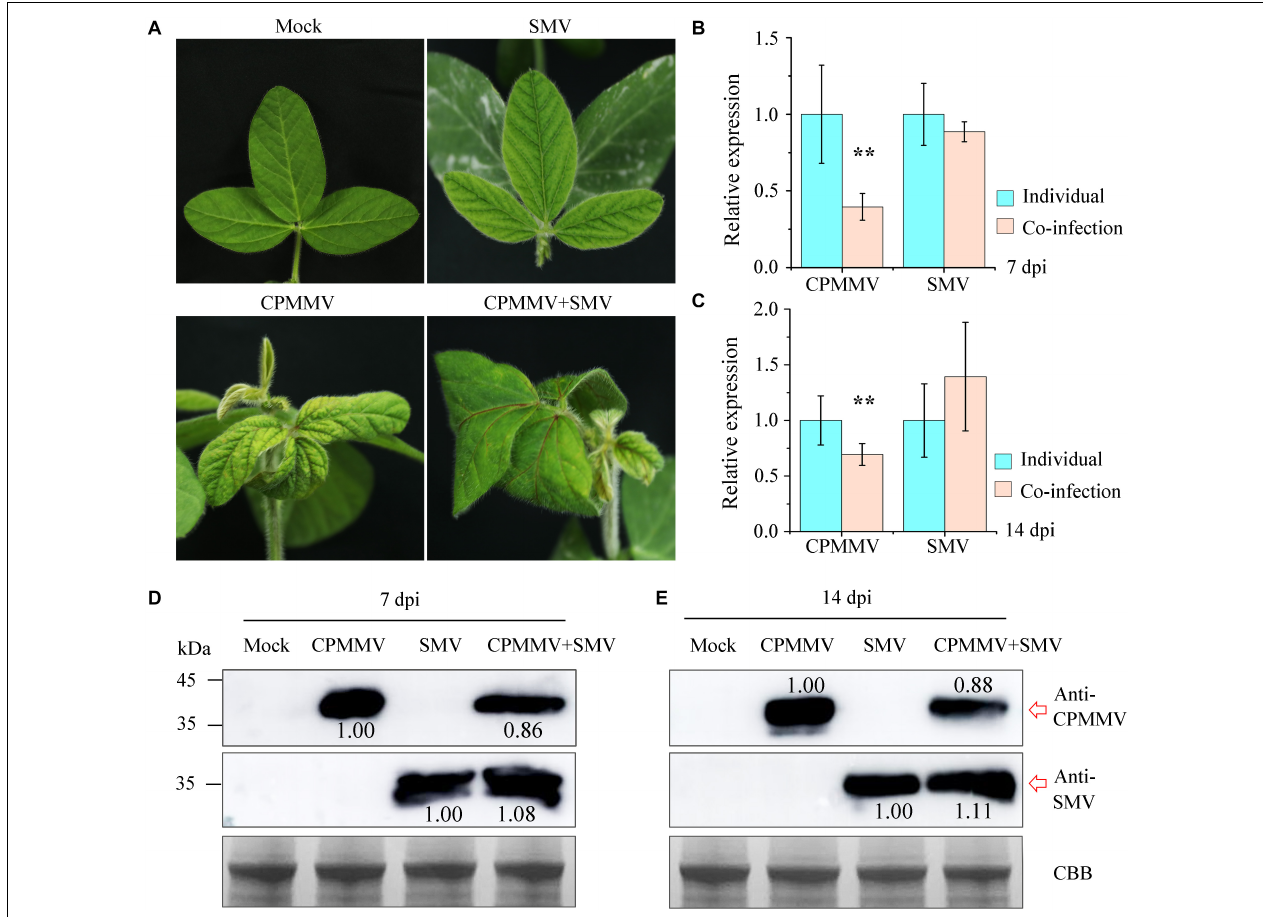
FIGURE 6 | Co-infection of CPMMV and SMV increased the accumulation of SMV. (A) Symptoms on the first newly-emerged leaves 7 days after inoculation with SMV, CPMMV or SMV+CPMMV. (B,C) The relative expression levels of SMV and CPMMV RNAs as determined by RT-qPCR at 7 dpi (B) and 14 dpi (C) . Data are shown as means ± SD of three biological replicates, ** P < 0.01, Student’s t -tests. (D,E) SMV and CPMMV coat protein (CP) protein levels in mock-inoculated and SMV/CPMMV-infected plants as determined by immunoblot analysis at 7 dpi (D) and 14 dpi (E) . Coomassie brilliant blue (CBB) staining of the same extracts is shown to demonstrate equal